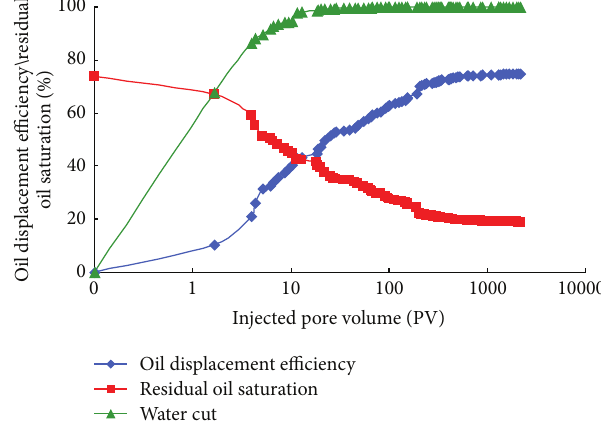
Figure 7: Oil displacement efficiency, residual oil saturation, and water cut with injected pore volume for 2000